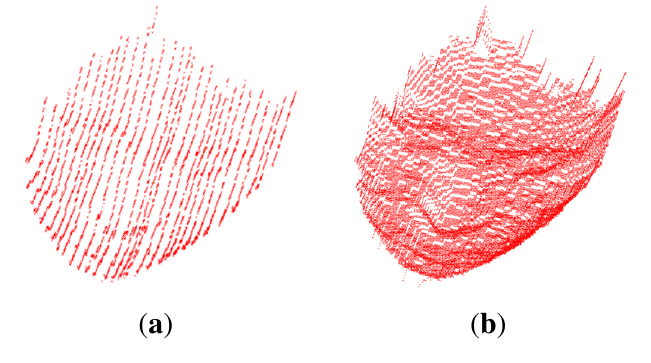
Figure 8. 3D face reconstruction results: ( a ) sparse map; and ( b ) dense map.